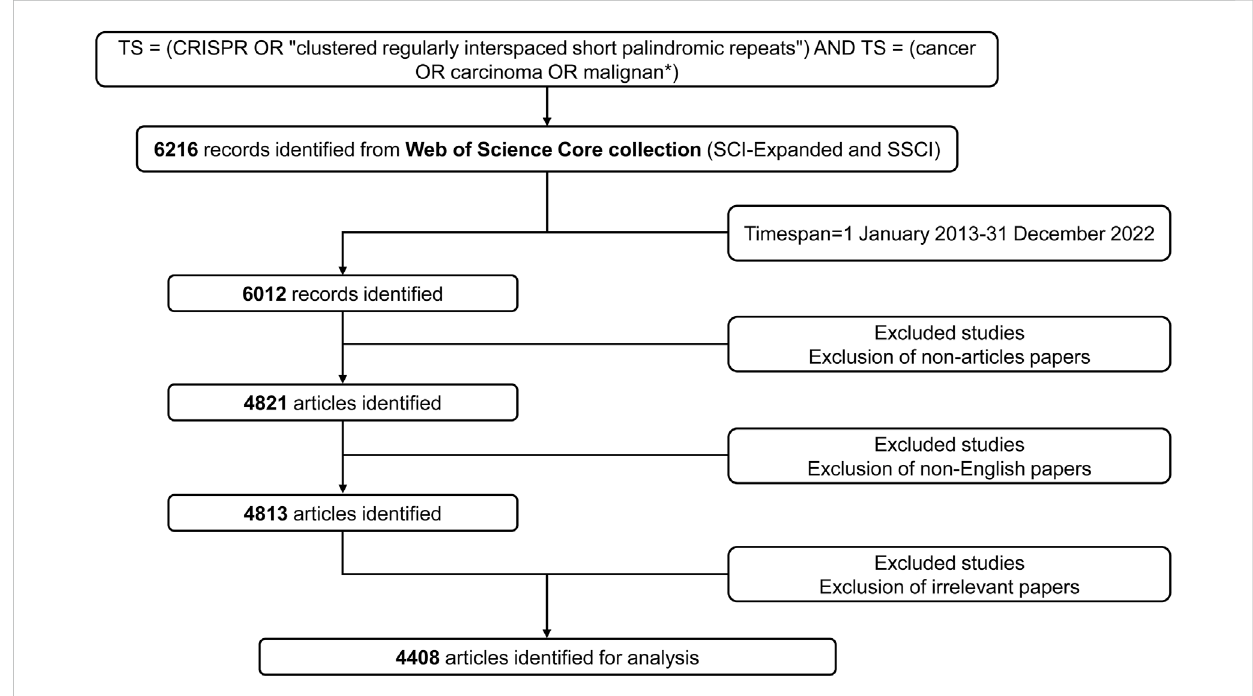
FIGURE 1 Flow diagram of literature screening related to CRISPR in